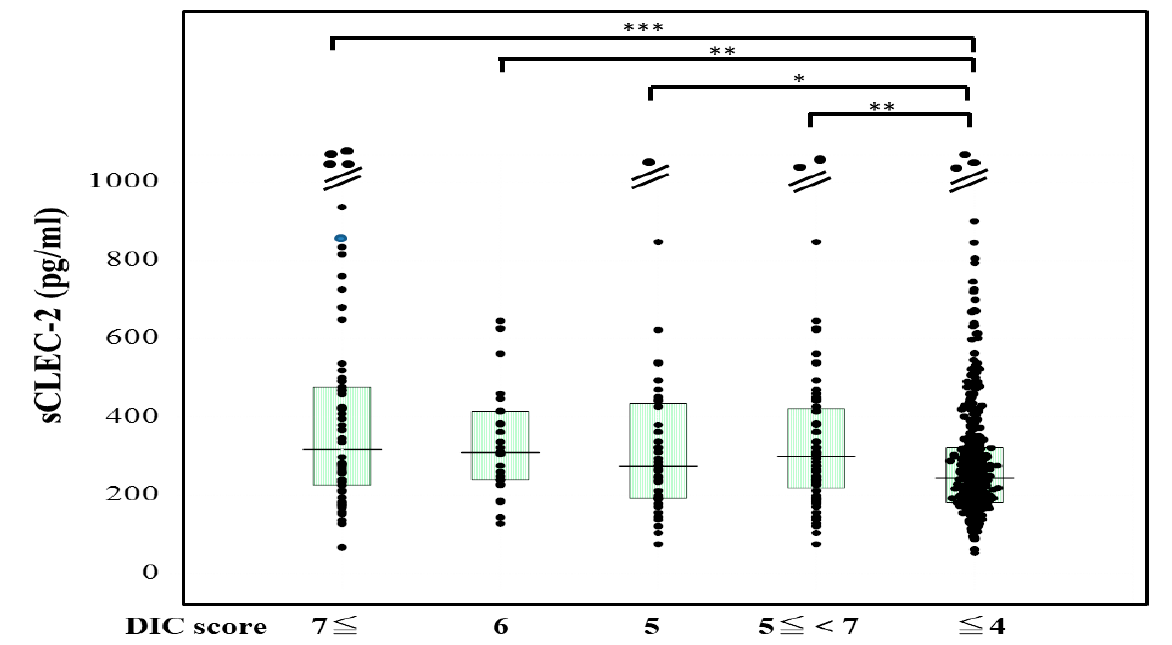
Figure 1. sCLEC-2 levels in patients with DIC, those with pre-DIC and those without DIC. DIC, DIC score ≥ 7; pre-DIC, DIC score 5 or 6; without DIC, DIC score ≤ 4; * p < 0.05; ** p < 0.01; *** p < 0.001.